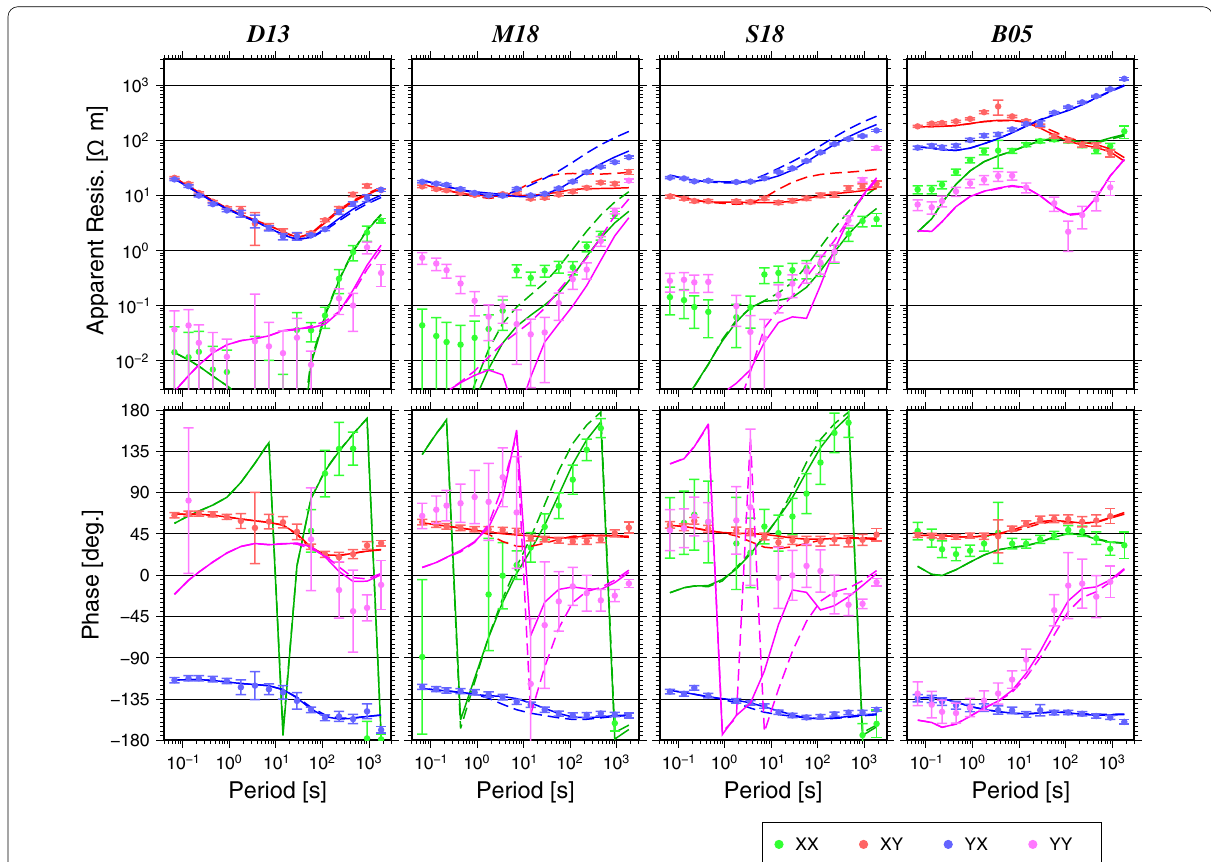
Fig. 2 Examples of sounding curves of apparent resistivity and impedance phase. Solid circles with error bars are observed impedances. Note that the error bars include error floors (see Sect. “3-D electrical resistivity inversion” for details). Solid lines are the responses of the inverted resistivity model and dashed lines are those for the sensitivity test model in which the C-2 anomalous zone (see Fig. 3) was assigned an apparent resistivity of 100 Ω m (see Sect. “Sensitivity test for resistivity